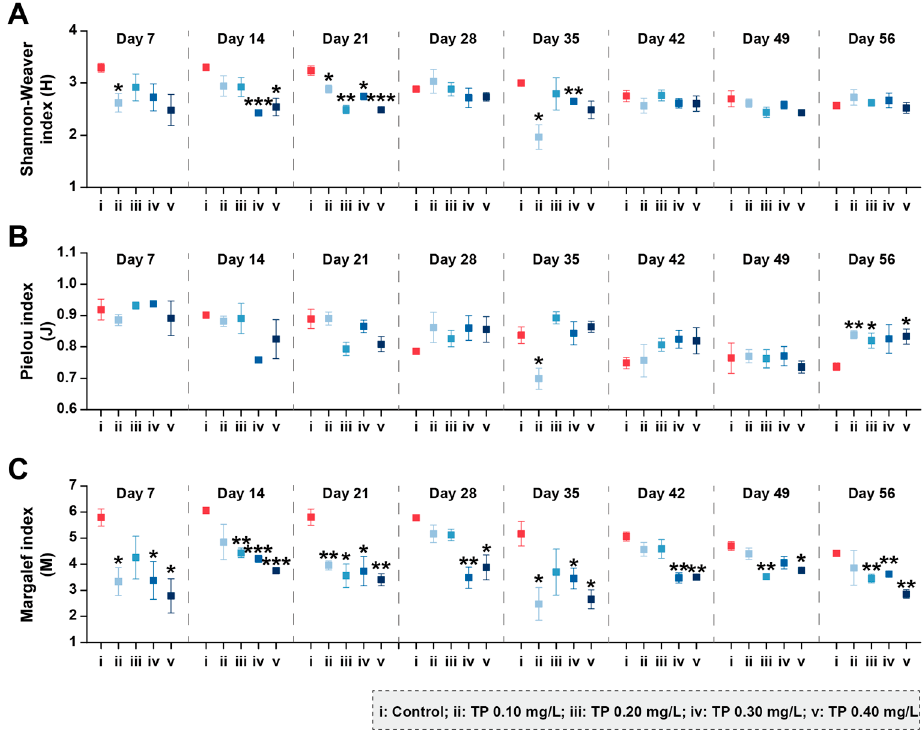
Figure 2. Shannon–Weaver diversity ( A ), Pielou evenness ( B ), and Margalef richness ( C ) of phyto- plankton communities under different TP concentrations. Significant differences are indicated in the figure, p ≤ 0.05 is marked as *, p ≤ 0.01 is marked as **, and p ≤ 0.001 is marked as ***.